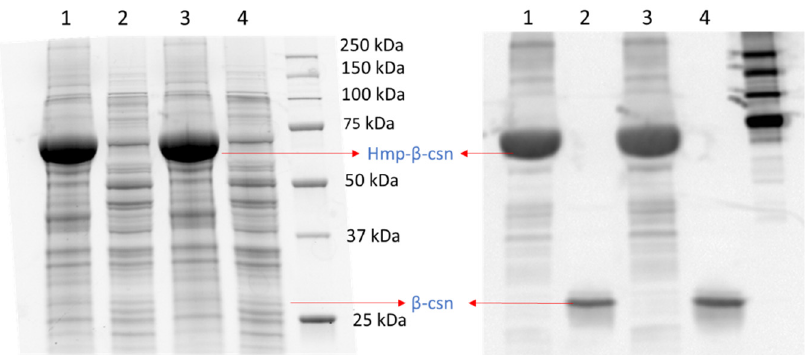
Figure 3. Hmp fusion increases the expression of β -csn. SDS-PAGE ( left ) and Western blot image ( right ) of same protein gel with cell lysates of wild-type E. coli harboring pQE80-P T5 - hmp- β -csn (pXW12) in lanes 1 and 3, and pQE80-P T5 - β -csn (pXW13) in lanes 2 and 4, with similar total protein quantity after 4 h of induction by 1 mM IPTG. Both Hmp- β -csn and β - csn contained C-terminal 6×His tags and Western blot was conducted with anti-His tag antibodies. Depicted are two in- dependent biological replicates in the same gel.